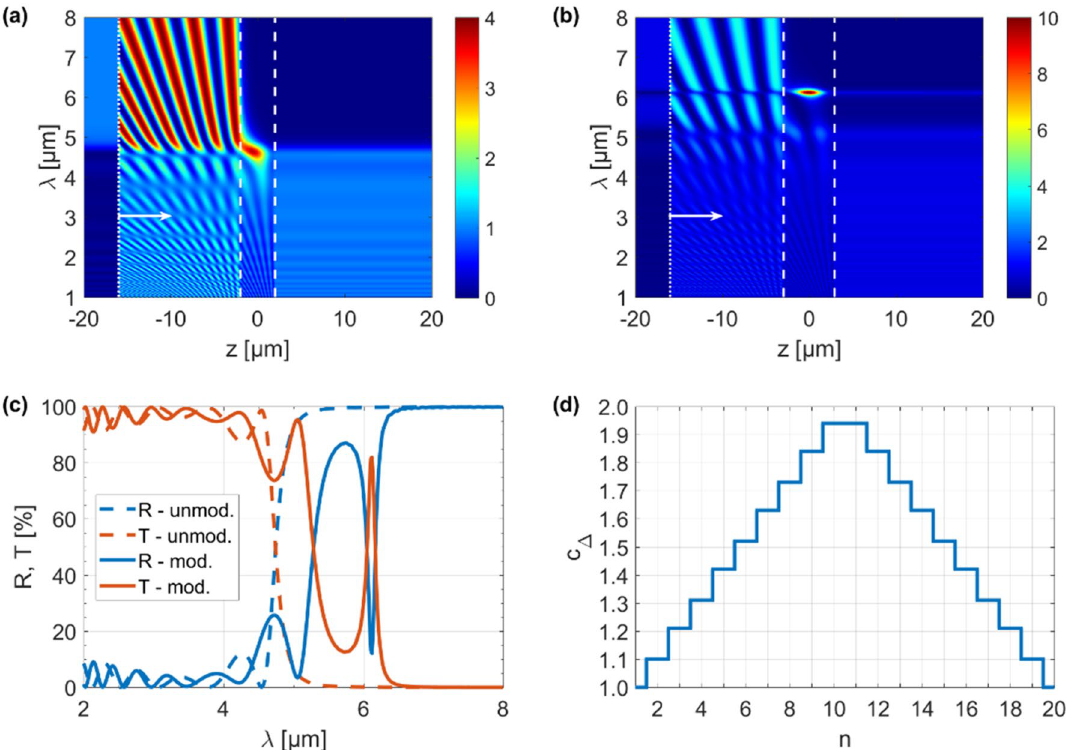
Figure 2. Electric field intensity for ( a ) unmodulated and ( b ) modulated structure, ( c ) their reflection and transmission comparison, and ( d ) triangle wave function coefficients used for the dielectric thickness